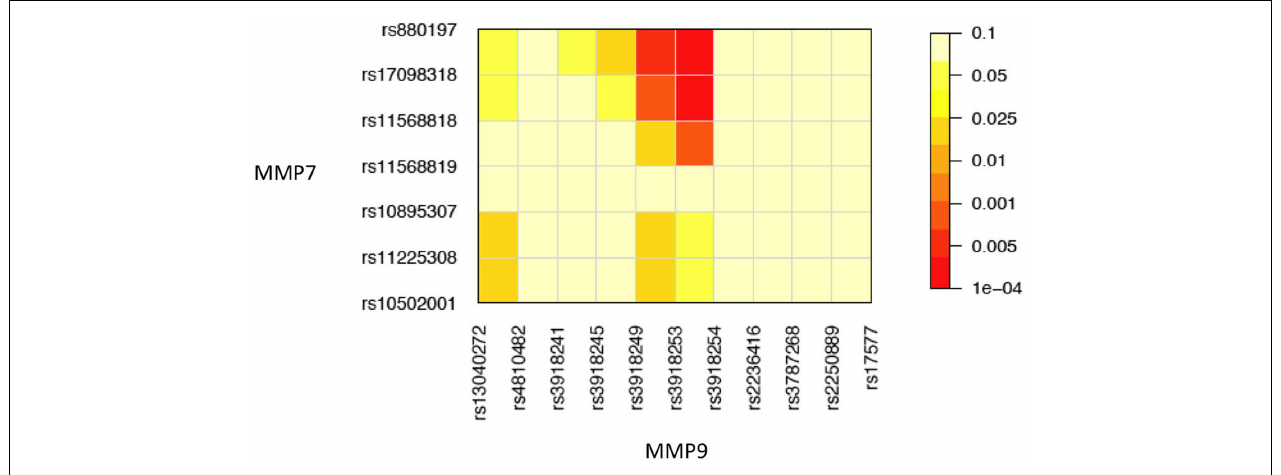
FIGURE 1 | Pairwise significance tests of additive × dominant epistasis between 7 SNPs at MMP7 and 11 SNPs at MMP9 in a genetic association study of sarcoidosis